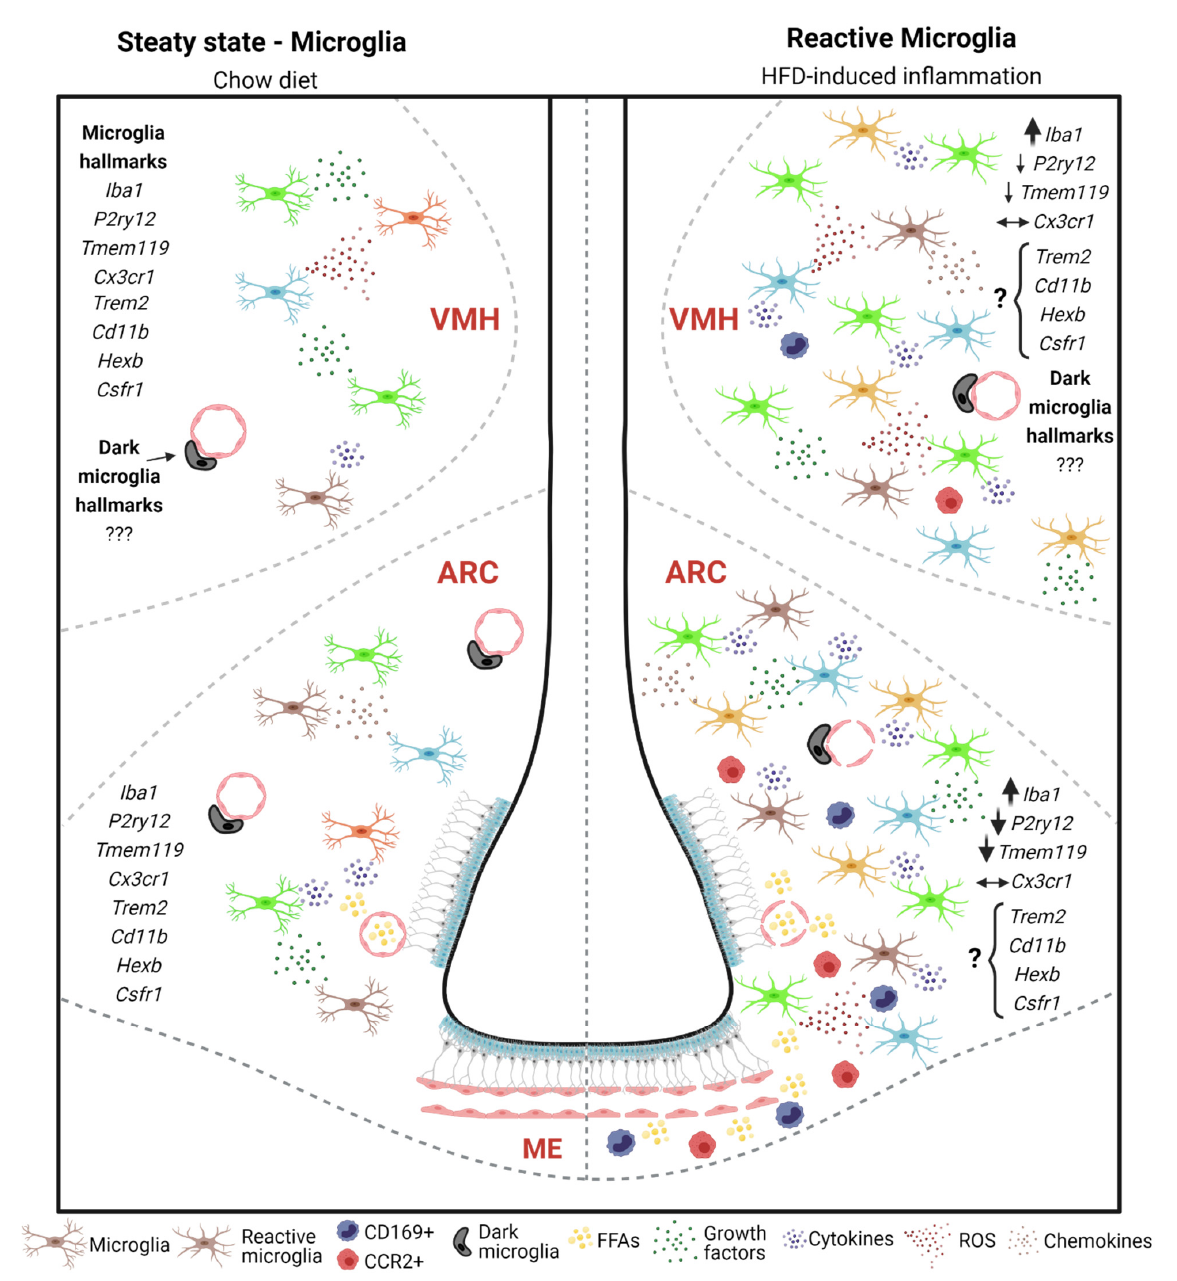
Figure 1. Microglial heterogeneity in the hypothalamus of rodents fed on chow or a high-fat diet (HFD). At steady state, microglia can be targeted by several hallmarks and are widely distributed in the hypothalamic parenchyma. Dark microglia (DM) are only visualized by transmission elec- tron microscopy and are close to blood vessels and neuronal synapses. Hallmarks of DM are well known in hippocampus, but remains barely explored in the hypothalamus. In HFD-induced hypo- thalamic inflammation, reactive gliosis is observed and microglia change their spatial distribution and molecular signature. Microglia cells react by increasing the release of pro-inflammatory cyto- kines, reactive oxygen species (ROS), and growth factors. In the ARC, ME, VMH, there is a huge increase in Iba1+ cells (wide arrow) and a decrease in P2ry12+ and Tmem119+ cells, which become more restricted to the VMH (thinner arrows when compared to their arrows in the ARC). How other microglial hallmarks (e.g., Trem2 , Cd11b , Hexb , Csfr1 , among others) behave under HFD have not been studied yet in this inflammatory process. The role of DM and changes in their hallmarks in this specific inflammatory response have still not been explored. A leaky blood–brain barrier